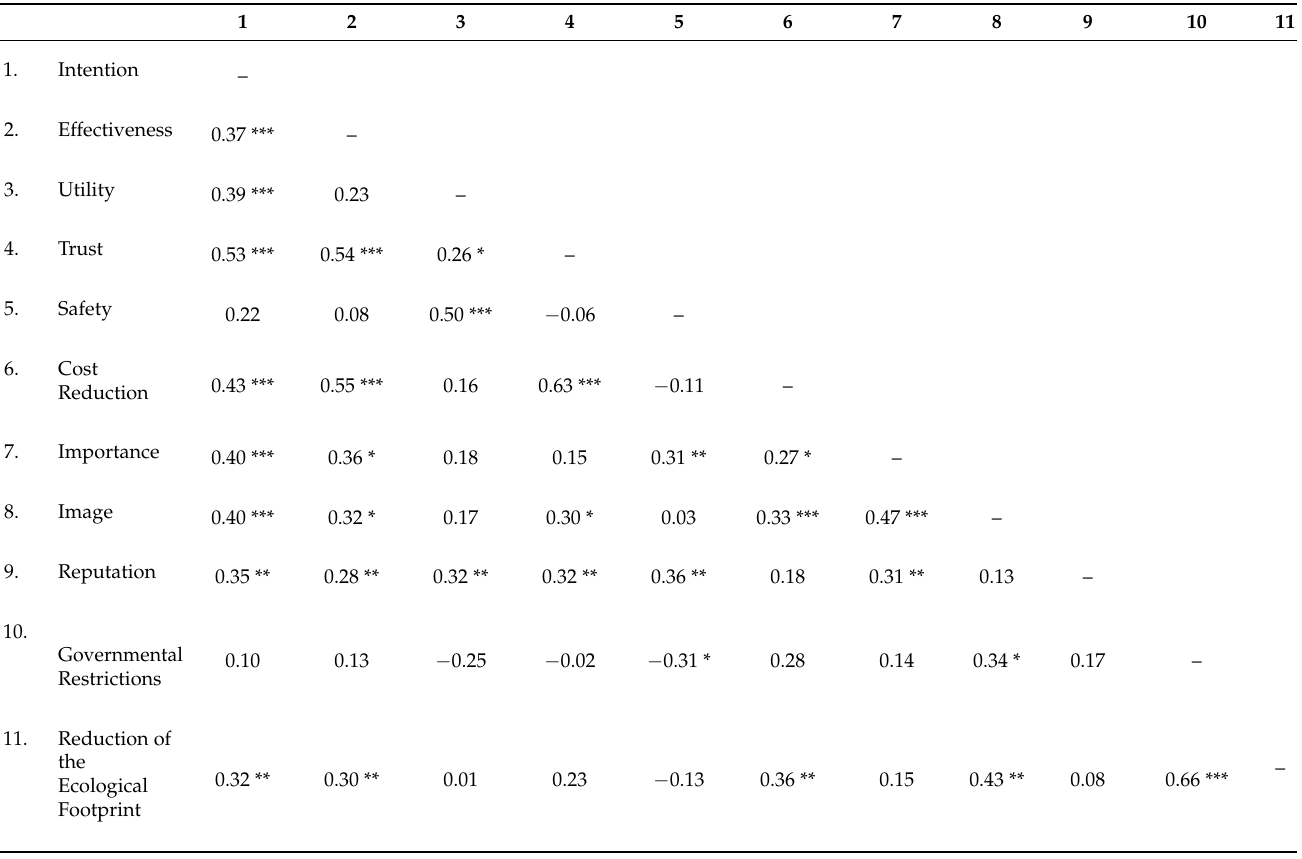
Table 2. Pearson Correlations—IBM SPSS Statistics